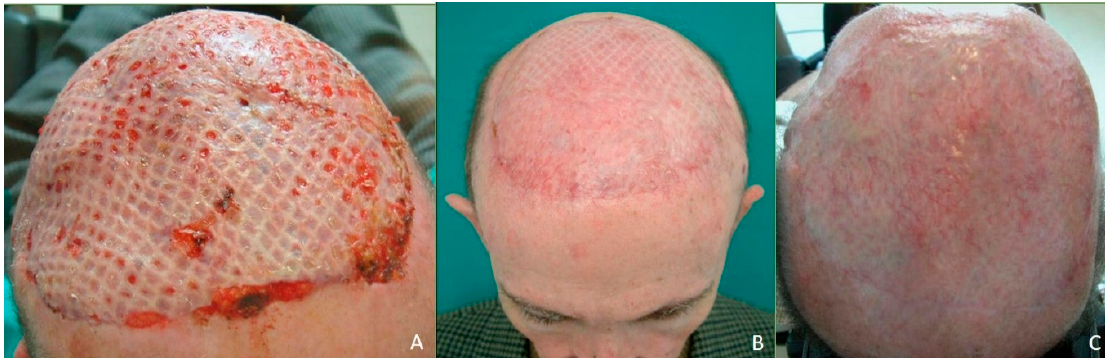
Figure 3. Omental flap. ( A ) Aesthetic result one-month post-operative. ( B ) Aesthetic result three-month post-operative. ( C ) Aesthetic result one year after reconstruction. No aesthetic distinction between the remaining scalp and the omental flap covered with skin graft. Good aesthetic result after extensive scalp reconstruction.